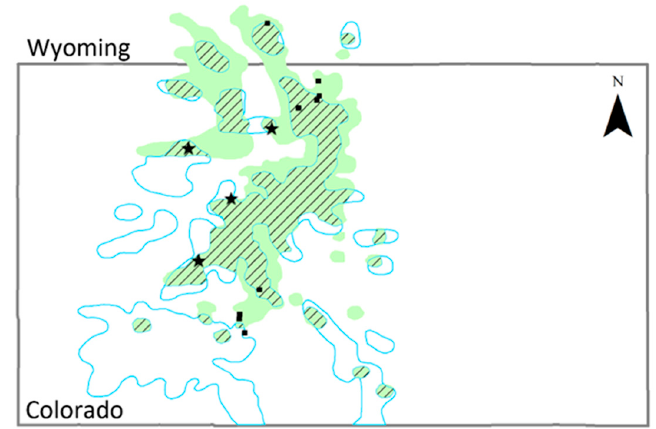
Figure 1. Southern Rocky Mountains sites were D. rufipennis was identified attacking P. contorta . Records from the 1940s and 1950s are indicated by stars, and squares indicate records made during this study. P. engelmannii (green) and P. contorta (blue) layers were modified from [13], trees intermix in the dashed areas.